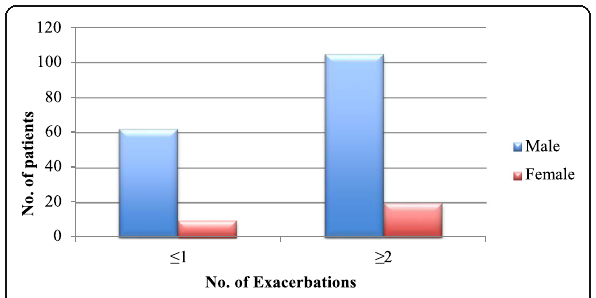
Fig. 3 Distribution of age with